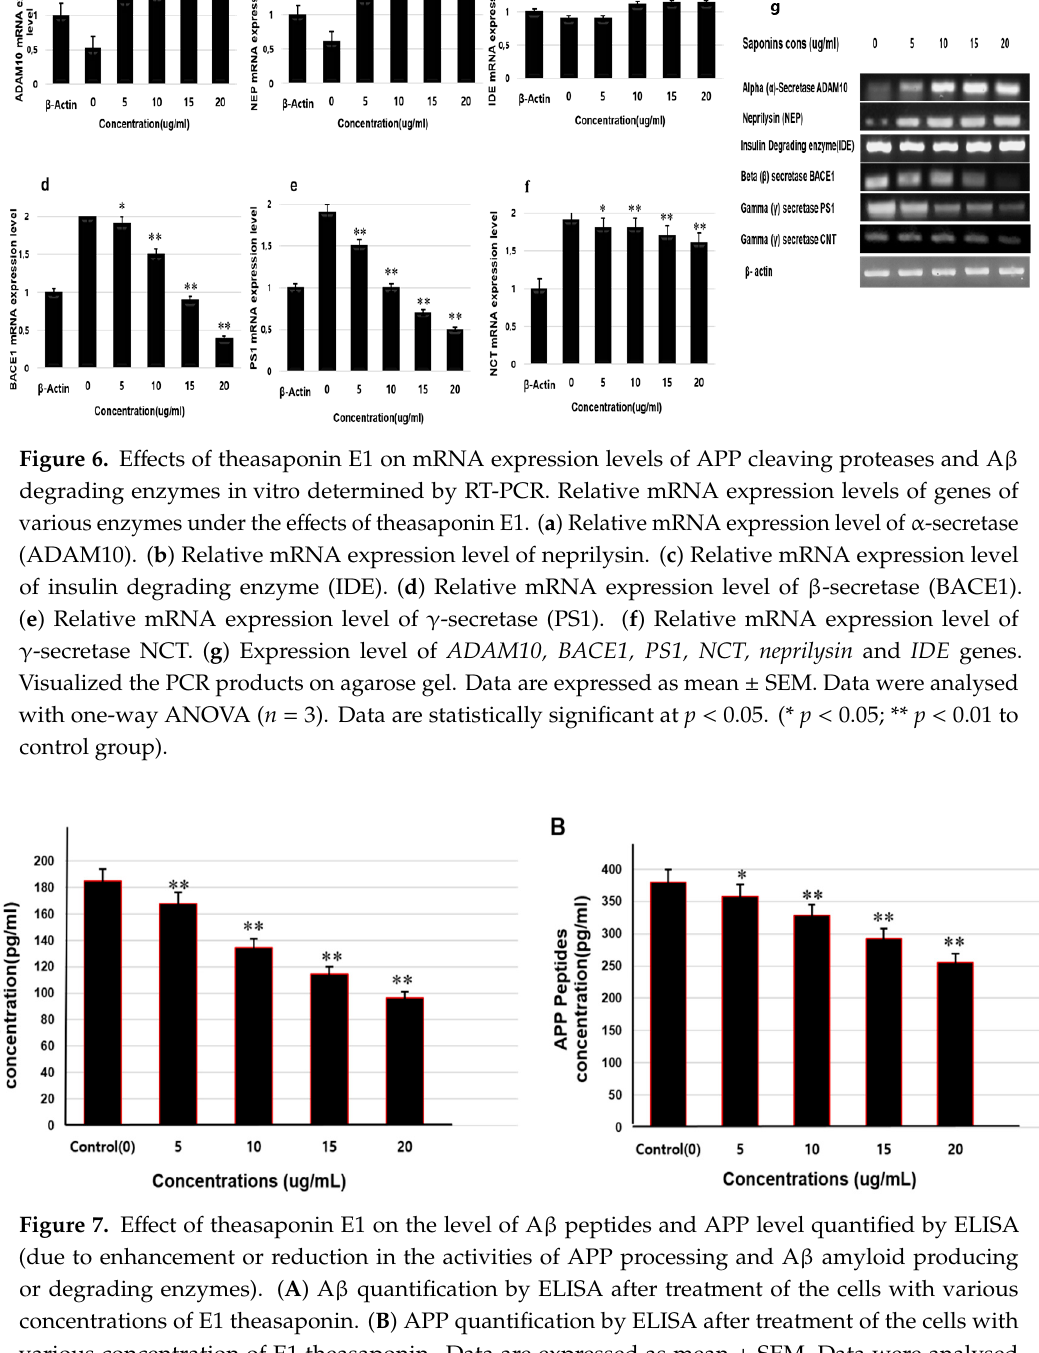
Figure 7. Effect of theasaponin E1 on the level of A β peptides and APP level quantified by ELISA (due to enhancement or reduction in the activities of APP processing and A β amyloid producing or degrading enzymes). ( a ) A β quantification by ELISA after treatment of the cells with various concentrations of E1 theasaponin. ( b ) APP quantification by ELISA after treatment of the cells with